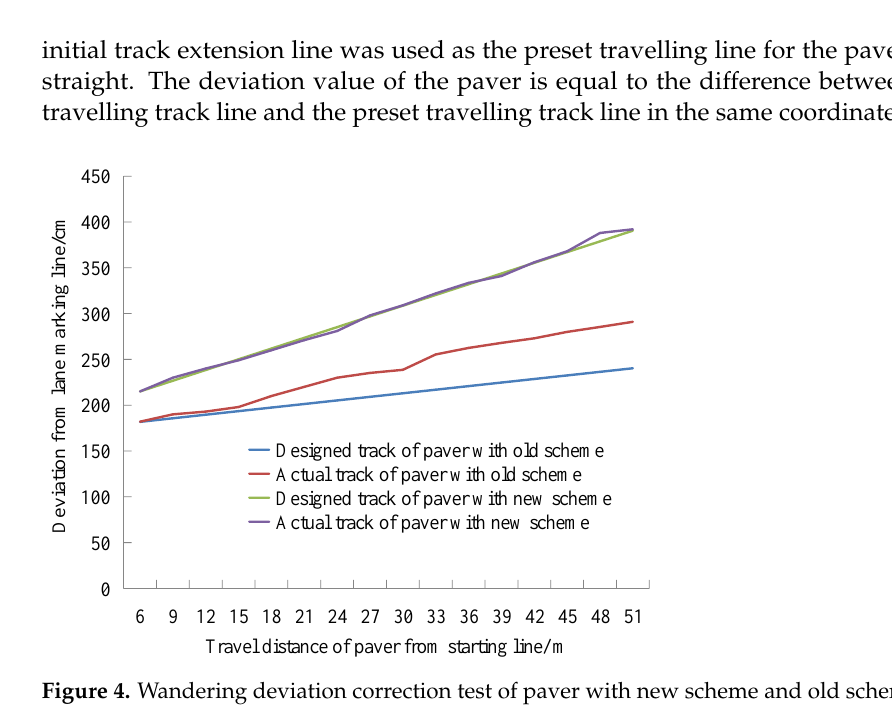
Figure 4. Wandering deviation correction test of paver with new scheme and old scheme.